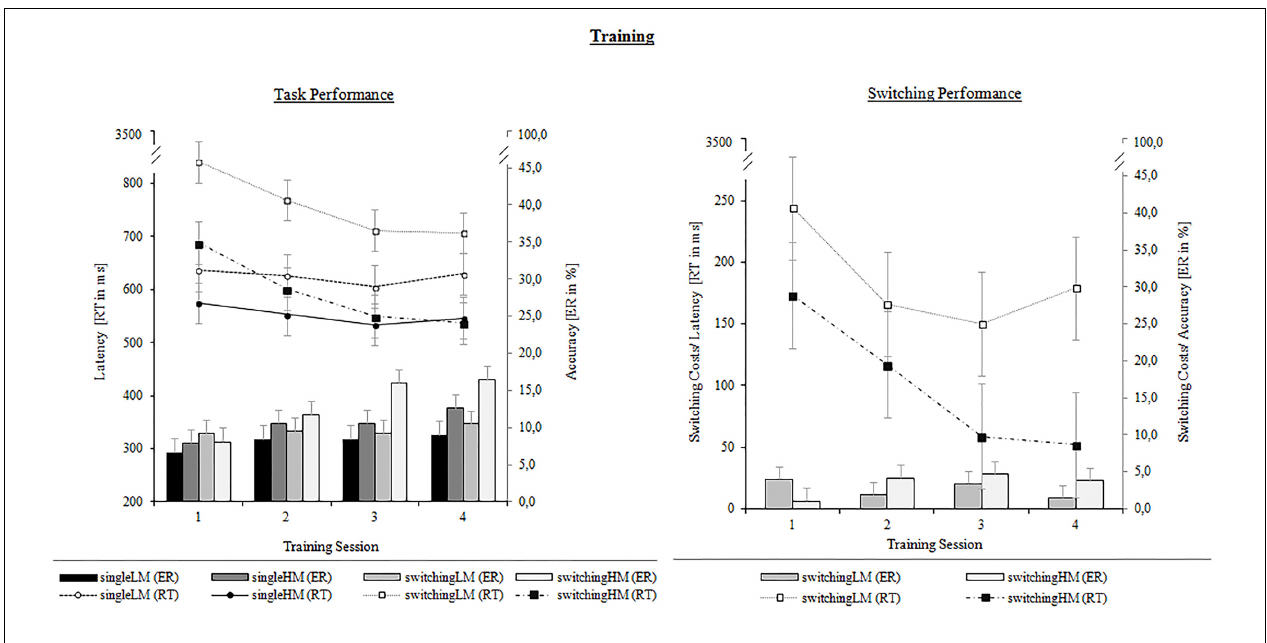
FIGURE 6 | Training performance on mean latencies (ms) and error rates (%) (left panel) as well as on latency and error switching costs (right panel) as a function of Training Group (single-LM, single-HM, switching-LM, switching-HM) and Training Session (1,2,3,4). Error bars